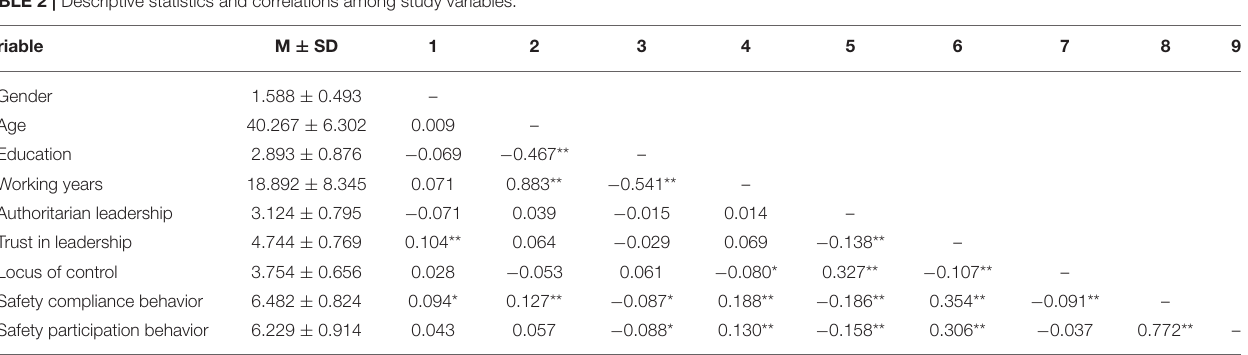
TABLE 2 | Descriptive statistics and correlations among study variables.